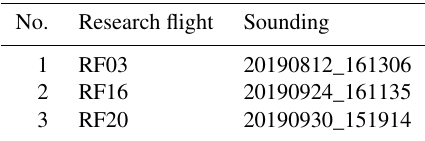
Table 4. Soundings where the GPS module